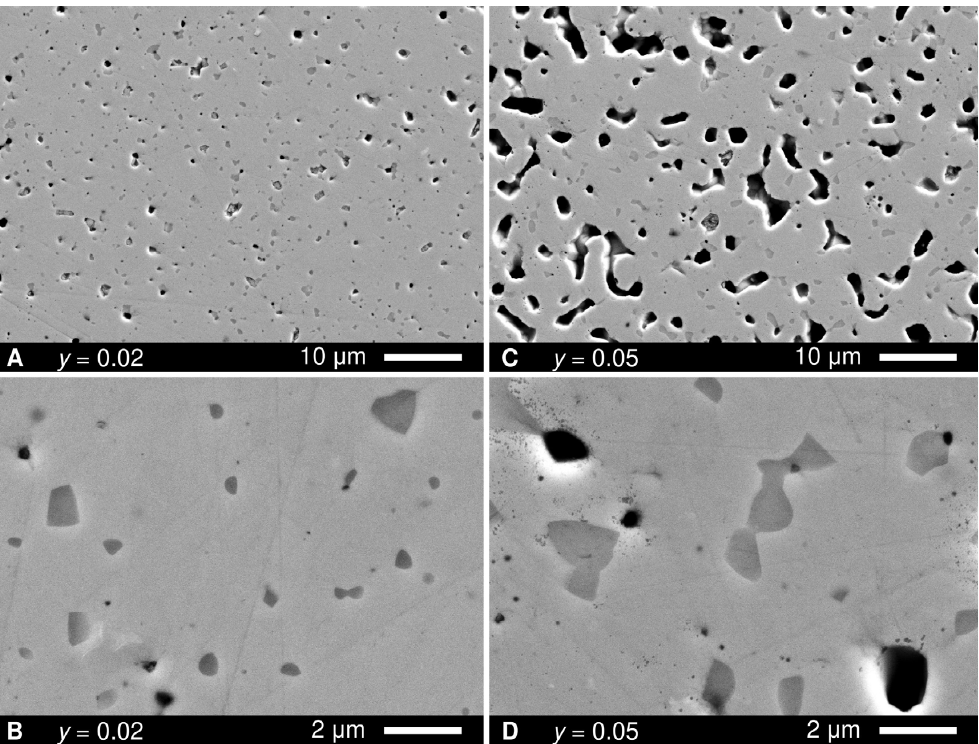
Figure 3. SEM images of polished La 2 Ni 1 − y Si y O 4+ δ ceramics.